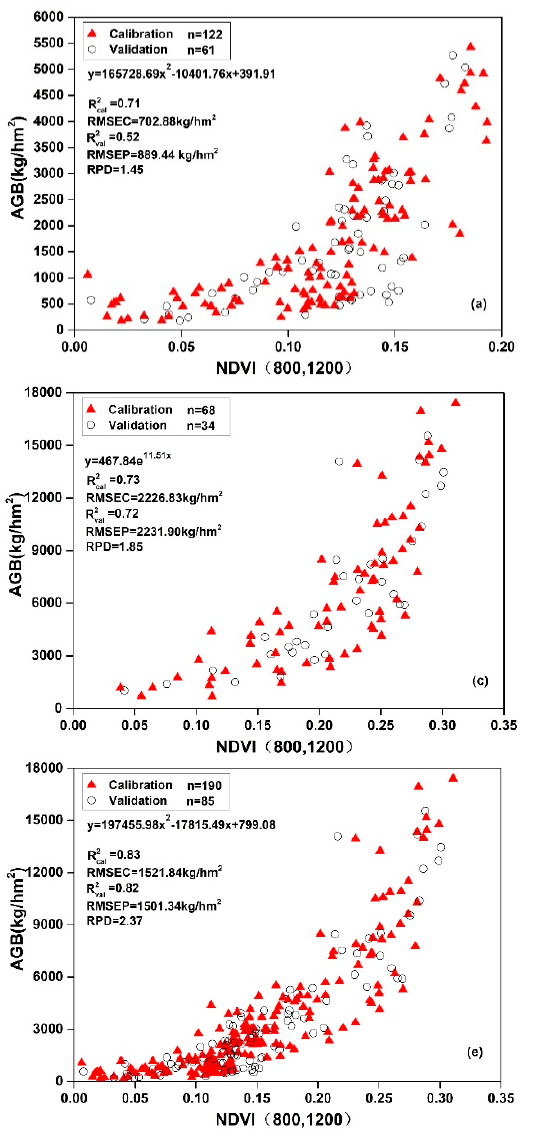
Figure 7. Regression modeling analysis between NDVI (800, 1200), CIred edge, and AGB at different stages: ( a ) model 33; ( b ) model 34; ( c ) model 35; ( d ) model 36; ( e ) model 37; and, ( f ) model 38.